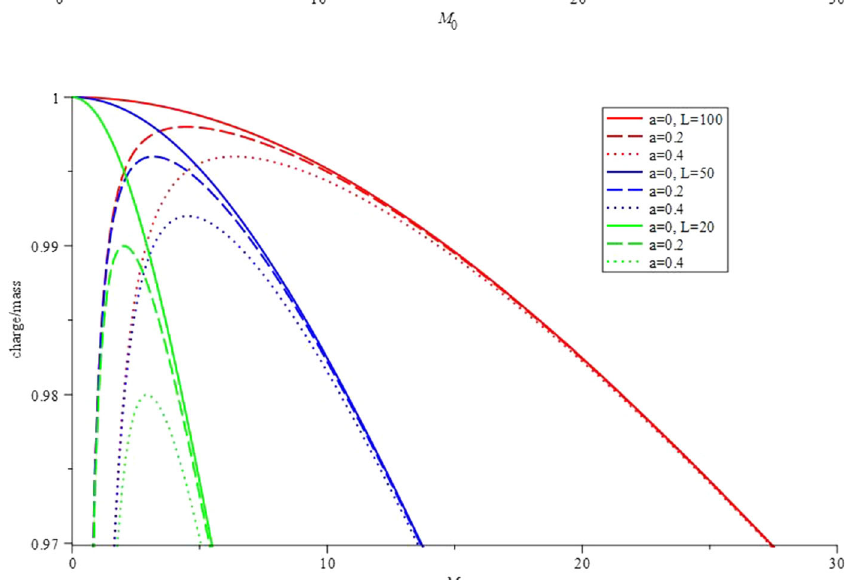
Fig. 4 Charge-mass ratio in AdS. For a given M 0 , the charge-mass ratio is smaller for a small AdS radius than for large AdS radius. The angular momentum a also lowers the charge-mass ratio for given M 0 and